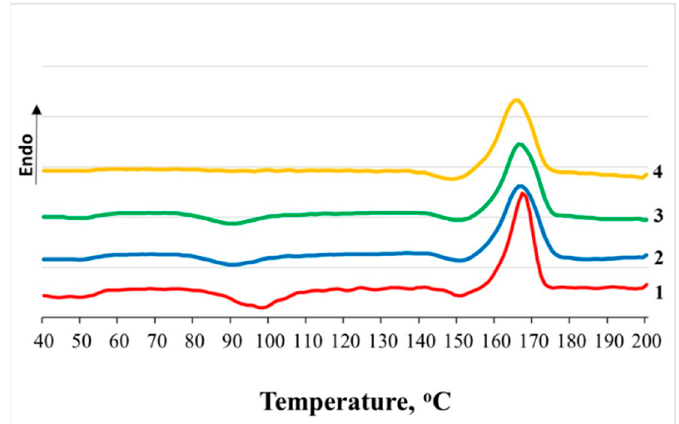
Figure 4. Melting thermograms of nonwoven PLA/NR fibers with different NR contents: (1) 0, (2) 5, (3) 10, and (4) 15 wt.%. 180 days of water degradation. DSC method.